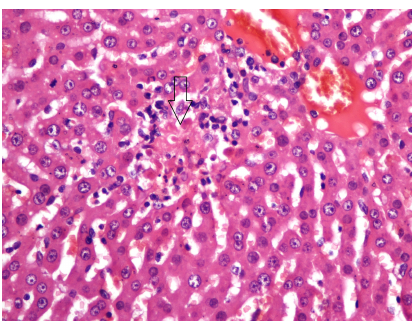
Figure 2. Photomicrograph of liver section showing the infiltration of mononuclear cells at portal area and dilated hepatic sinusoids. (H&E × 200)